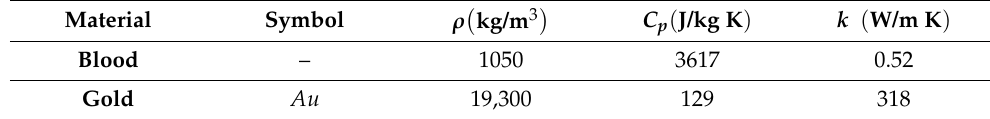
Table 1. Base fluid (blood) and nanoparticle experimental values [10]. Material